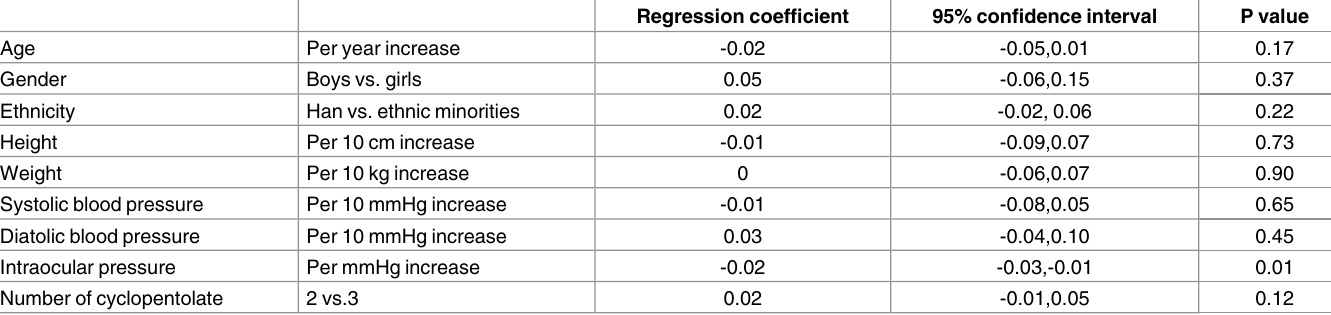
Table 3. Associations of amount of errors due to non-cycloplegic refraction with demographic, systemic and ocular